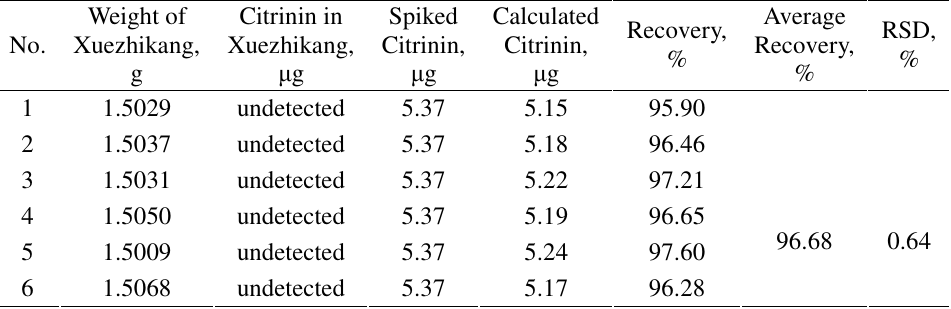
Table 4. The result of recovery